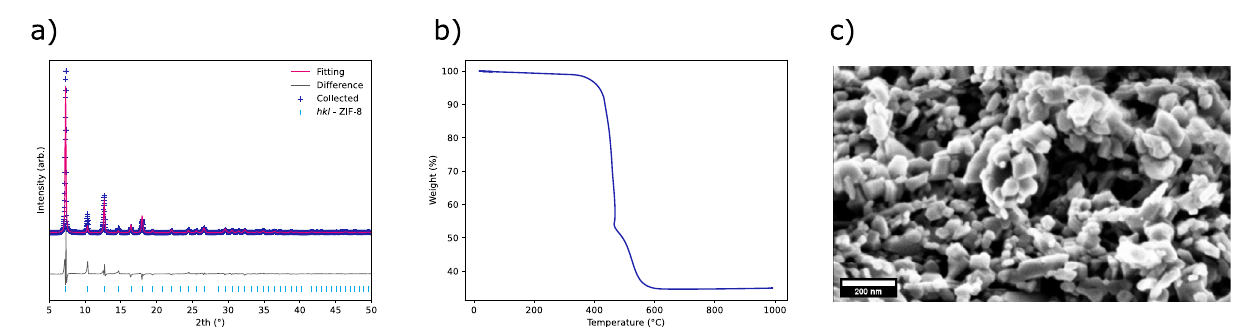
Fig. 10 Various data collected on the large-scale batch. a Collected PXRD pattern and subsequent Rietveld re fi nement, b TGA trace of nano ZIF-8 material and c SEM micrograph taken of nano ZIF-8 material all from the one-kilogram batch of nano ZIF-8 produced via the transformation from ZIF-L. Table 2 BET surface area values for ZIF-L and ZIF-8 produced via the original and new